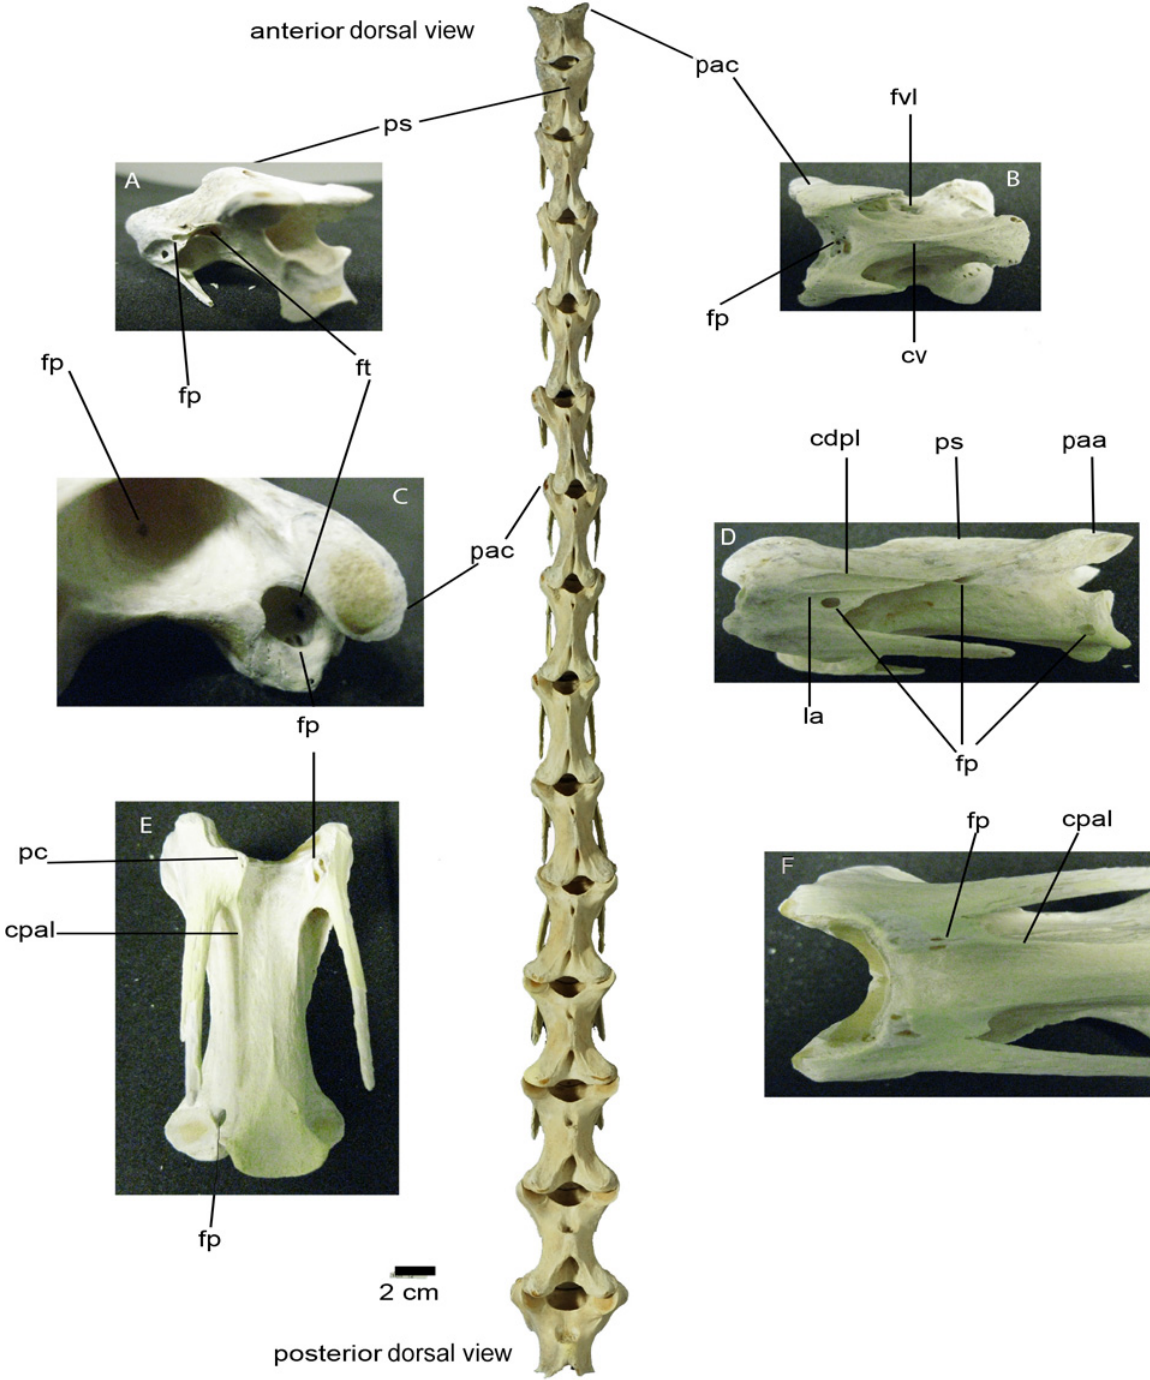
Fig 1. Dorsal view of ostrich ( Struthio camelus ) cervical column. (A) Posterolateral view of CV4 (BRS MG Ag1174.2), revealing the foramen pneumaticum ventral to the lamina arcocostalis , the foramen pneumaticum ventral to the processus transversus, and the foramen transversarium ; note the vertebral foramen located posterior to the processus spinosus ; (B) Ventral view of CV3 (BRSMG Ag1174.1) from which the foramen vertebrale laterale , the crista ventralis that runs along the corpus , and the pneumatic foramina on the anterior-most margin of the vertebral foramen can be viewed; (C) Left anteroventral view of a cervical vertebra (CV10: BRSMG Ag1174.8) exposing the pneumatic foramen on the inner wall of the vertebral foramen and the multiple pneumatic foramina within the costotransverse ring; (D) Left ventrolateral view of CV5 (BRSMG Ag1174.3) showing the centrodiapophyseal lamina, the lamina arcocostalis just above the pneumatic foramen on the arcocostal surface's posterior-most margin, and a pneumatic foramen on both the corpus along the line of the neurocentral suture and on the posterolateral surface of the cotyle; (E) Ventral view of CV11 (BRSMG Ag1174.9) exposing the